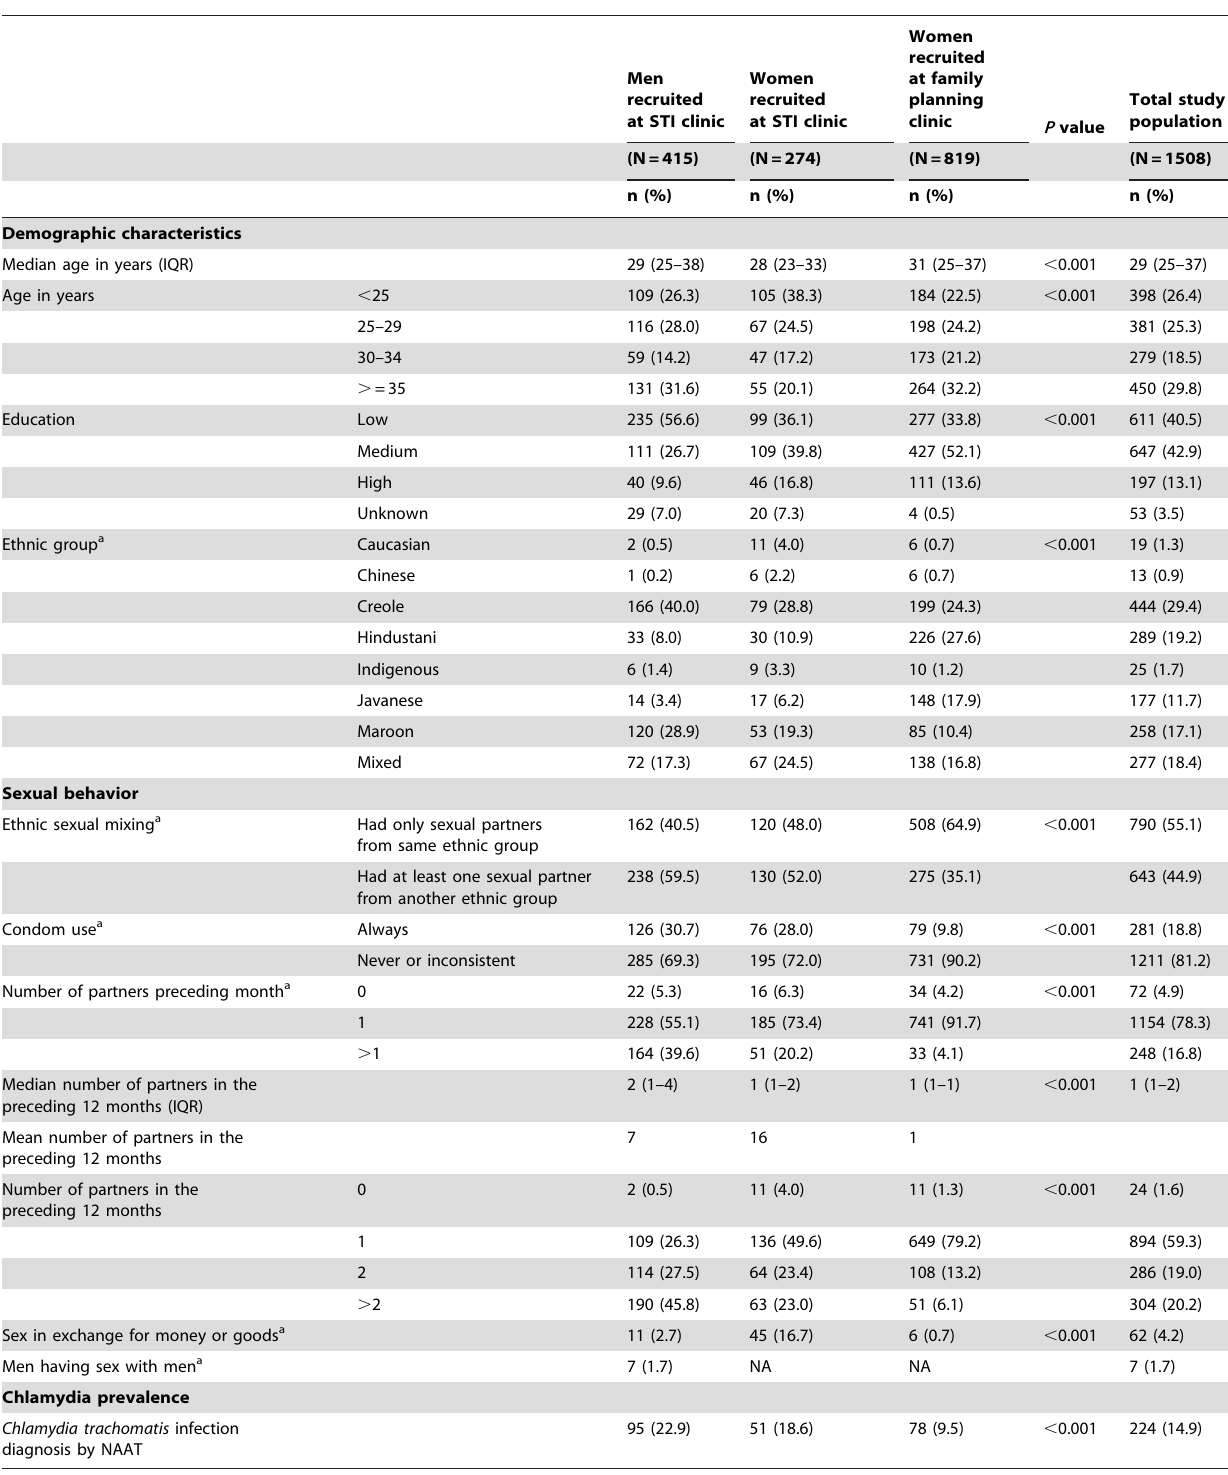
Table 1. Epidemiological characteristics of the study population by study group in Paramaribo, Suriname,